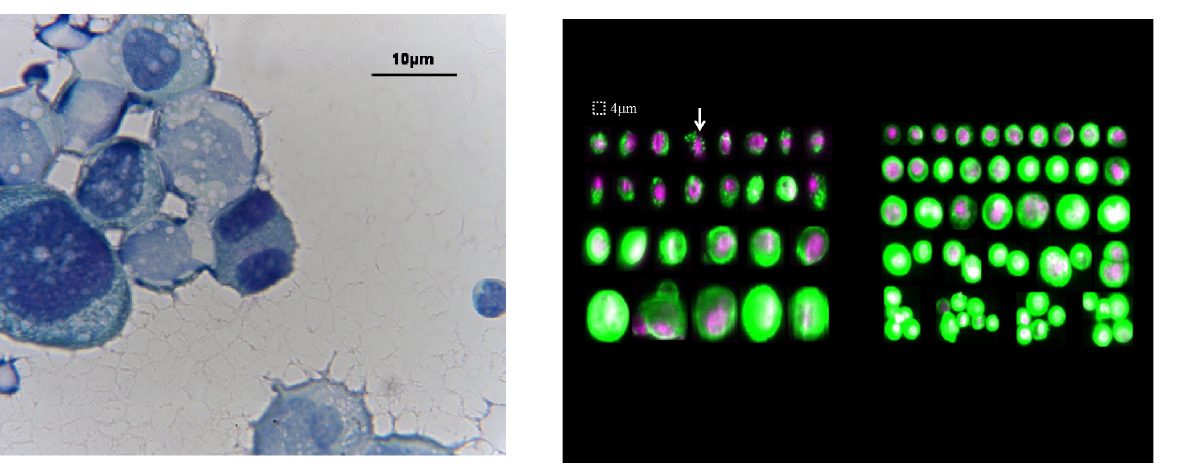
Figure 3. Gallery of images of tumor cells in peripheral blood (left) and ascites (right) detected by CellSearch ® technology. By definition, CTCs are nucleated (purple color), express cytokeratin (green color), and lack CD45 expression. Some of the CTCs in blood sample presented morphologically apoptotic figfeatures. Arrow, shrunken cell containing CK inclusions. But in the ascitic sample, positive cells were either isolated or in clusters and their morphology was very similar to that of CTCs in the peripheral blood though without apoptotic